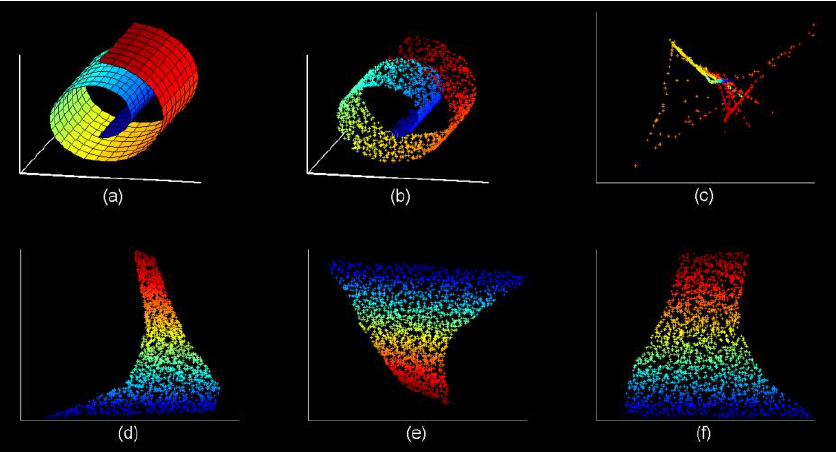
Figure 3. The effect with different choices for parameter k on dimensionality reduction performance: ( a ) Swiss roll, ( b ) 2000 sampling points, ( c ) k = 4, ( d ) k = 12, ( e ) k = 36, ( f ) self-adaptive k.